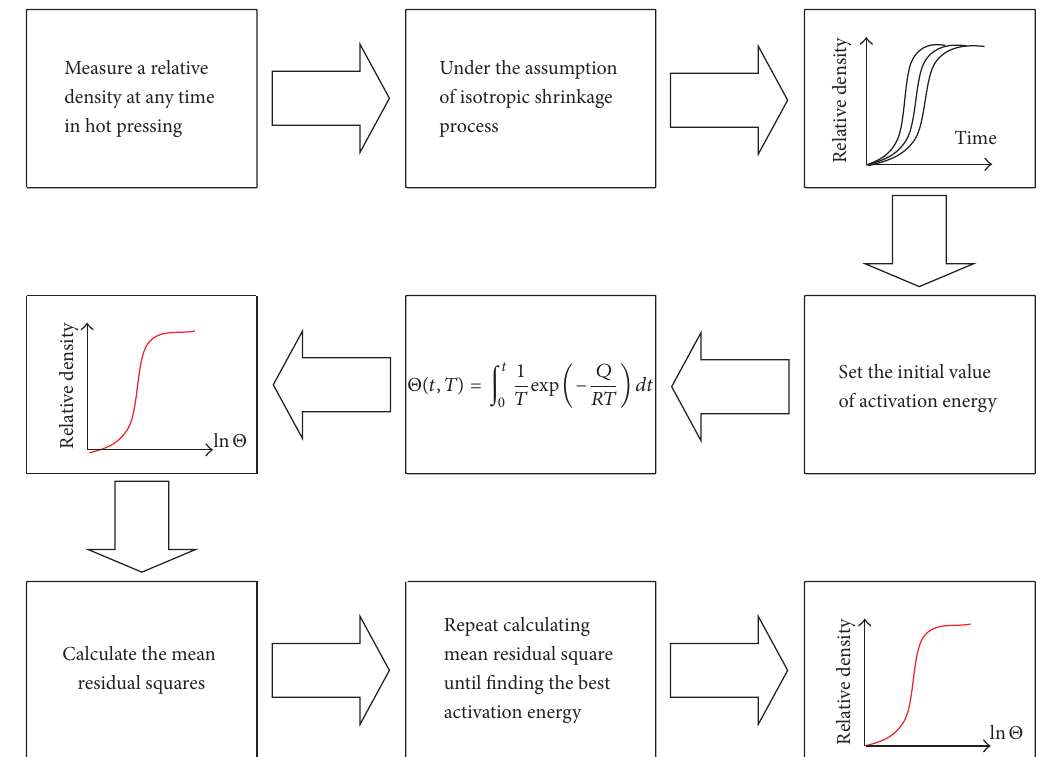
Figure 1: The overall procedure for the construction of a master sintering curve.